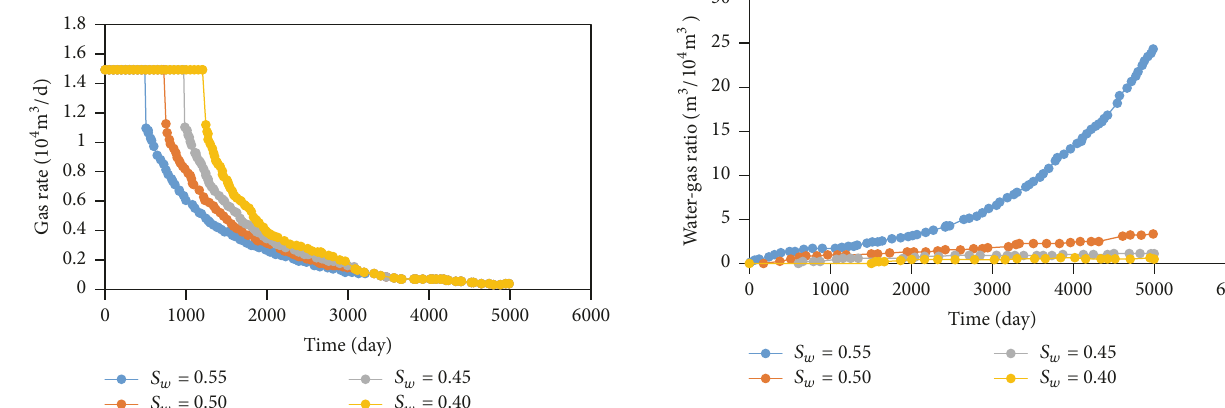
Figure 18: Effect of water saturation on gas-water ratio.